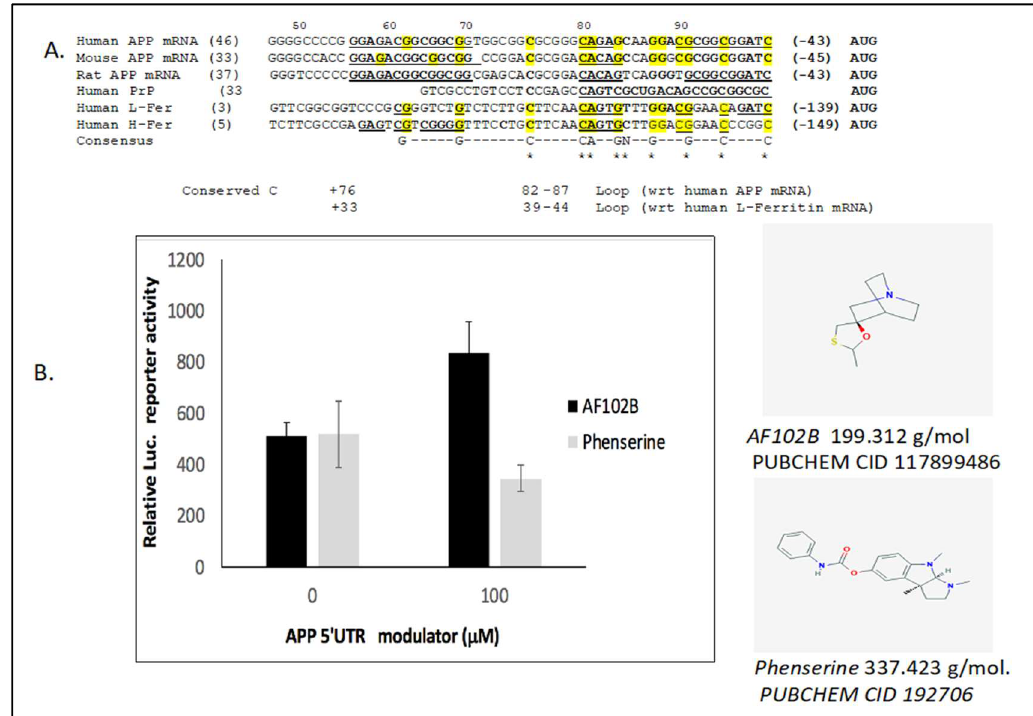
Figure 2. The effect of AF102B and phenserine to modulate amyloid precursor protein (APP) conferred expression via the 5’untranslated region (5’UTR) of the APP transcript. Adapted from Rogers et al. (2005) [57]. ( Panel A ) Phylogenetically conserved sequences (underlined; [11]) encoding the